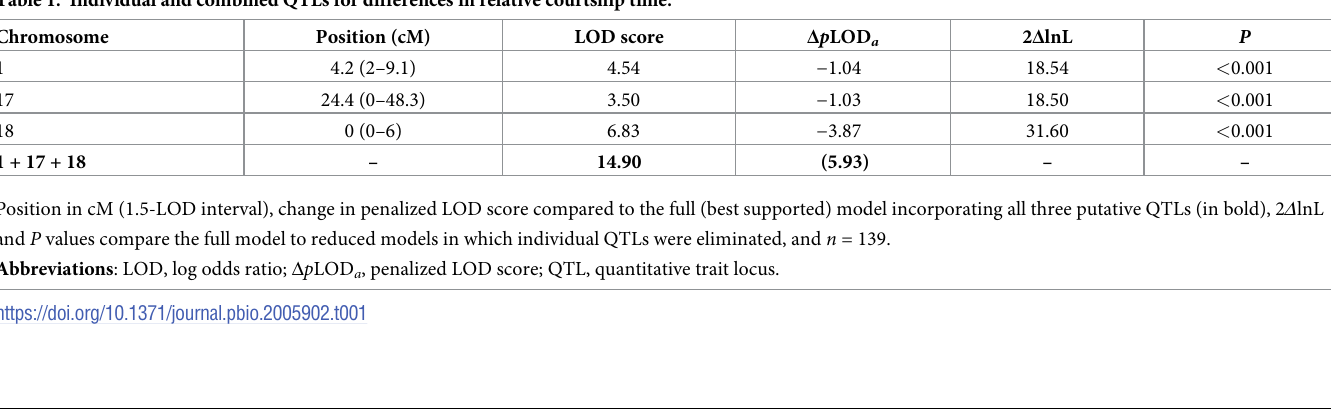
Table 1. Individual and combined QTLs for differences in relative courtship time. Chromosome Position (cM)